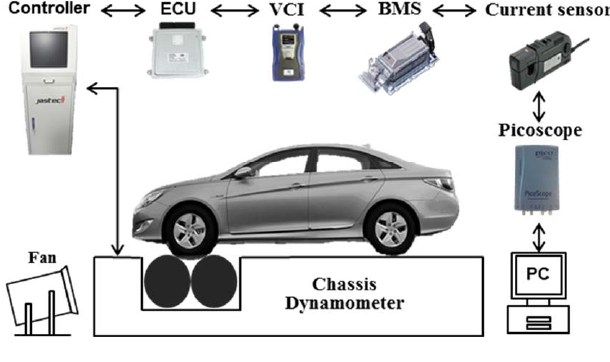
Figure 4. Schematic of experimental setup.